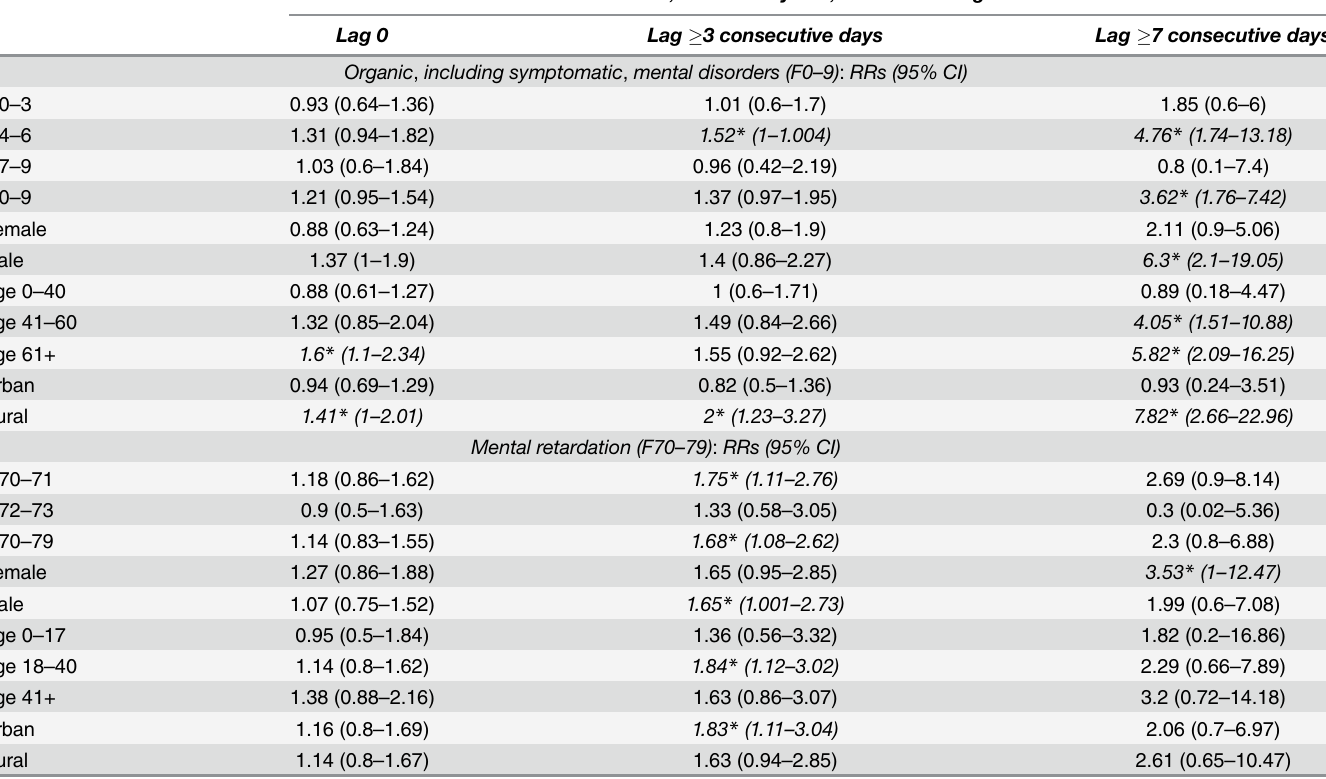
Table 3. Admissions for F0-9 and F70-79 by daily maximum temperature at lags reaching or exceeding 35°C, stratified by sex, location, and age